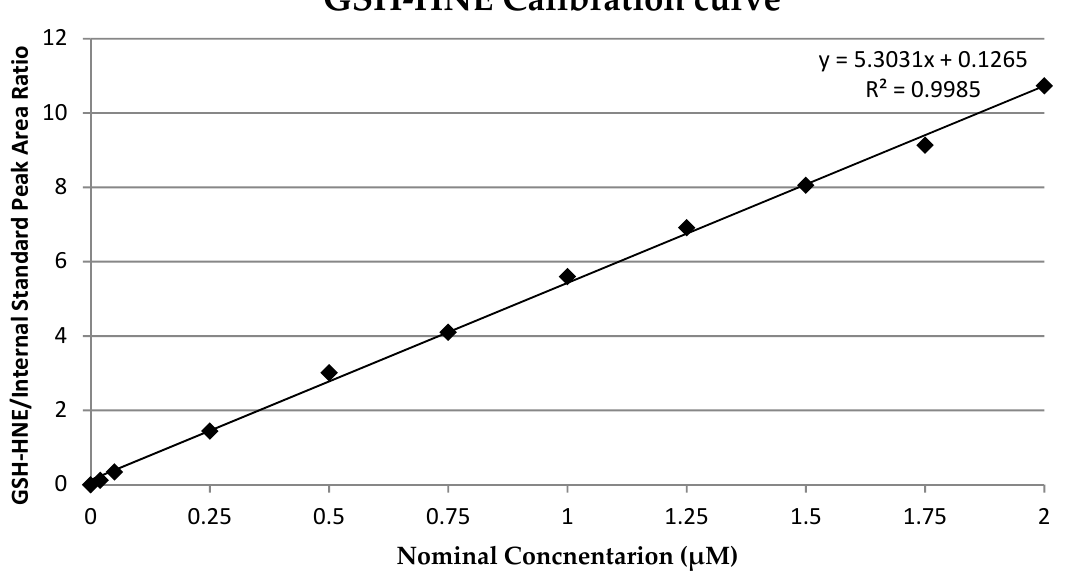
Figure 2. Glutathion and 4-hydroxynonenal (GSH-HNE) calibration curve.